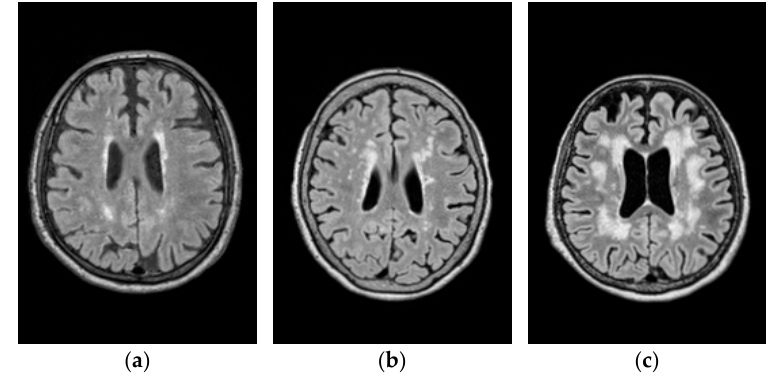
Figure 11. Lesion categorized by three grades of Fazekas shown in FLAIR images. ( a ) Fazekas grade 1; ( b ) Fazekas grade 2; ( c ) Fazekas grade 3